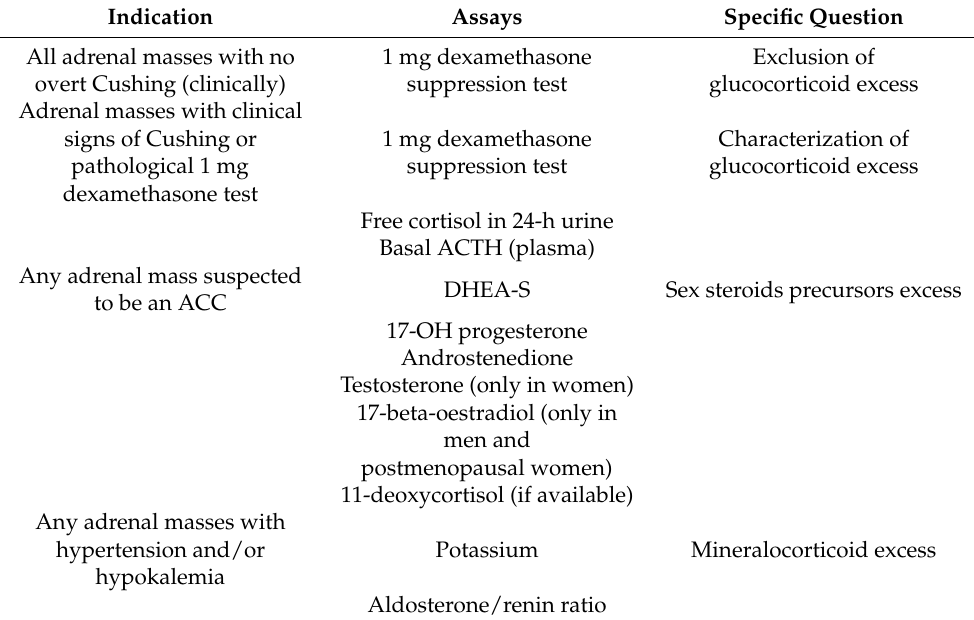
Table 1. Diagnostic (hormonal) work-up of suspected adrenal malignancies (modified according to 2020 guidelines